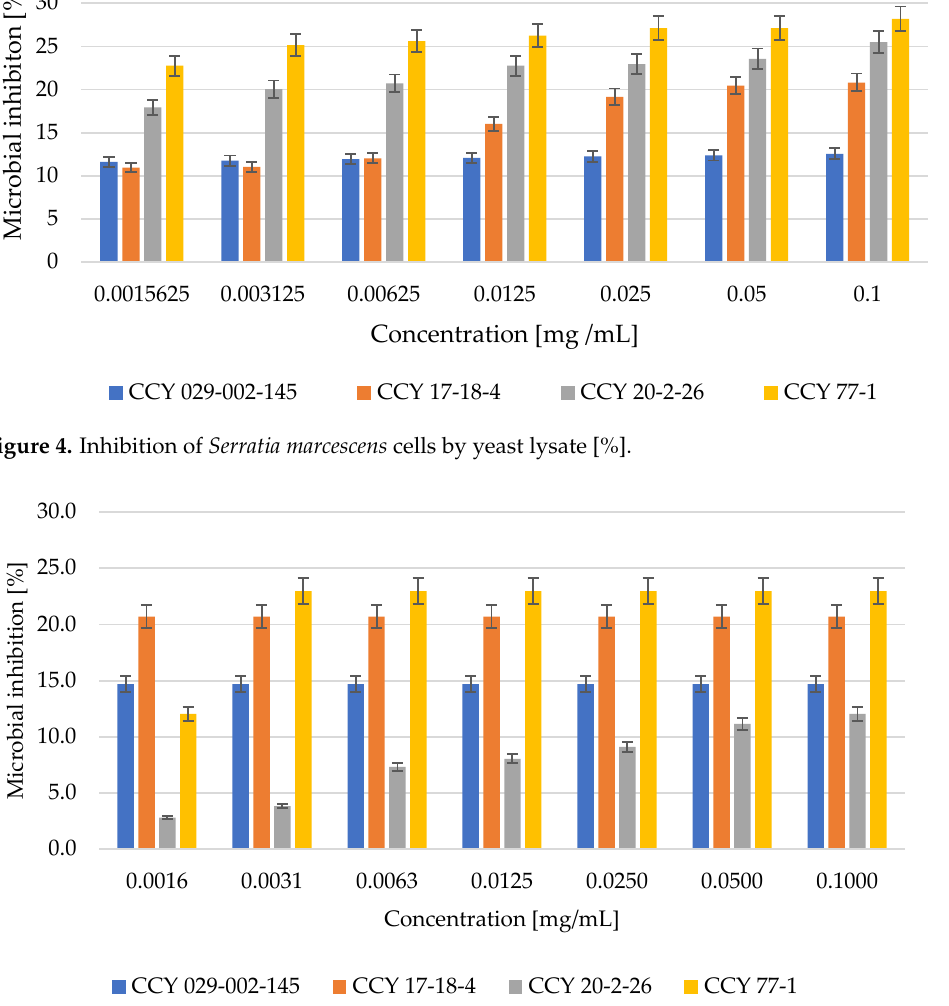
Figure 5. Inhibition of Micrococcus luteus cells by yeast lysate [%].